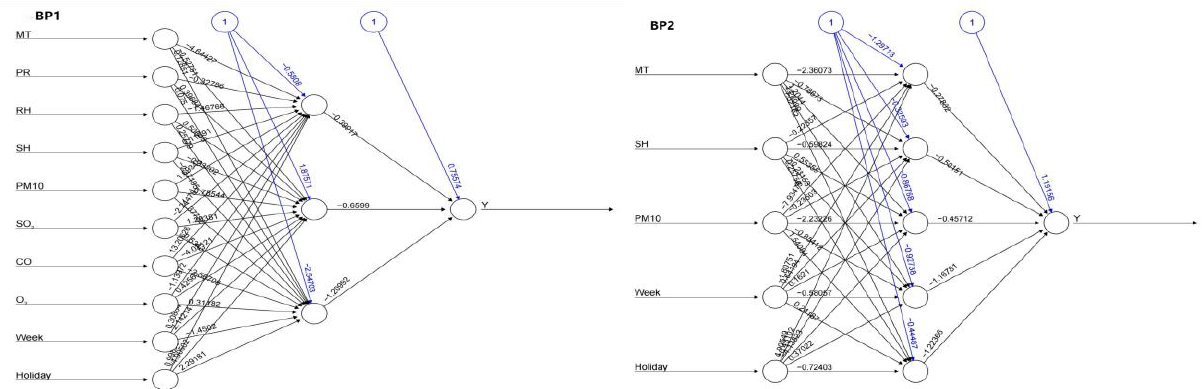
Figure 7. Structure diagram of BP neural network model (BP1/BP2).